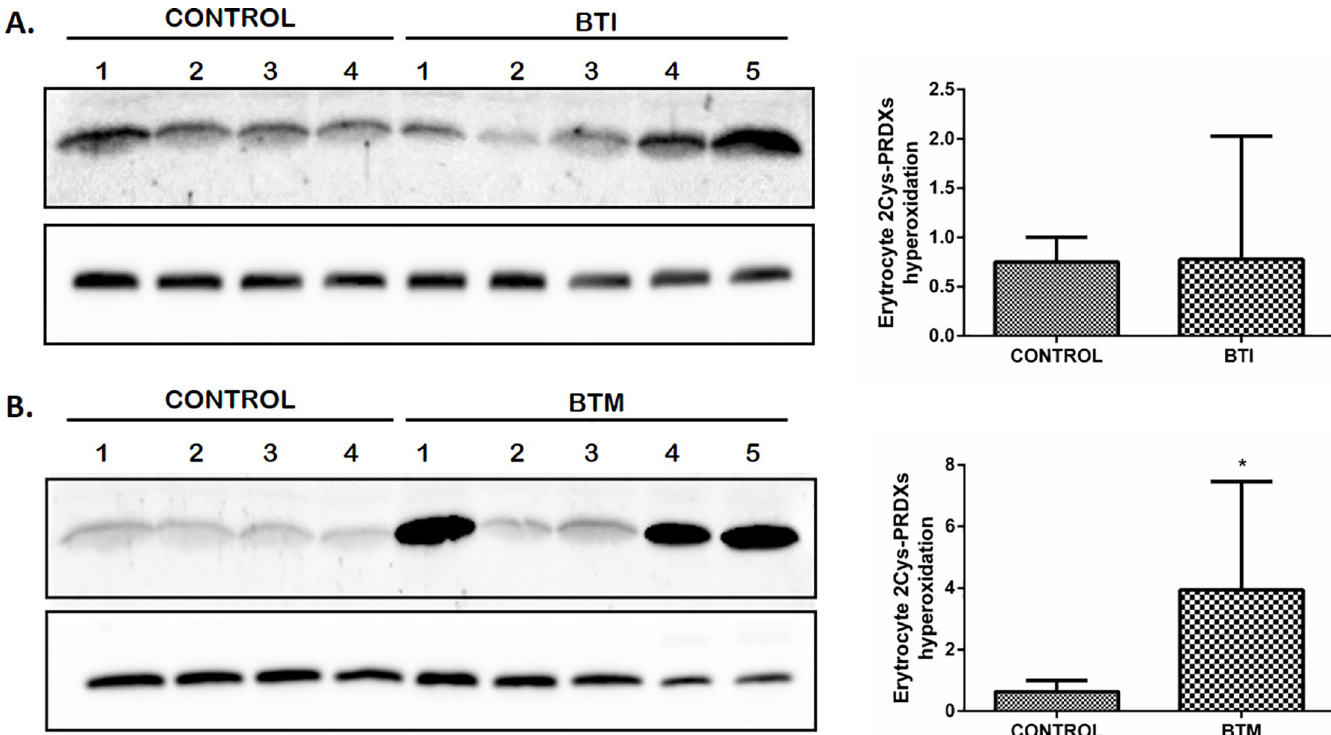
Fig 6. Hyperoxidation of 2Cys-Prdx is altered in patients BTM. Representative western blot for hyperoxidation state of 2CysPrdx. Erythroid cells of BTI (A) and BTM (B) patients were lysed in the presence of 200 uM of Nethylmaleimide (NEM) to prevent further sample oxidation. Hyperoxidation levels were measured using 50 μ g of total protein from each sample running in a 12% (w/v) reducing SDS–PAGE. The intensity of the bands was measured using GAPDH as the endogenous control. Quantitative analyzes were performed by densitometry using ImageJ Software [35]. Results are presented as mean and standard error ( ± SEM). Statistical significance: � p <